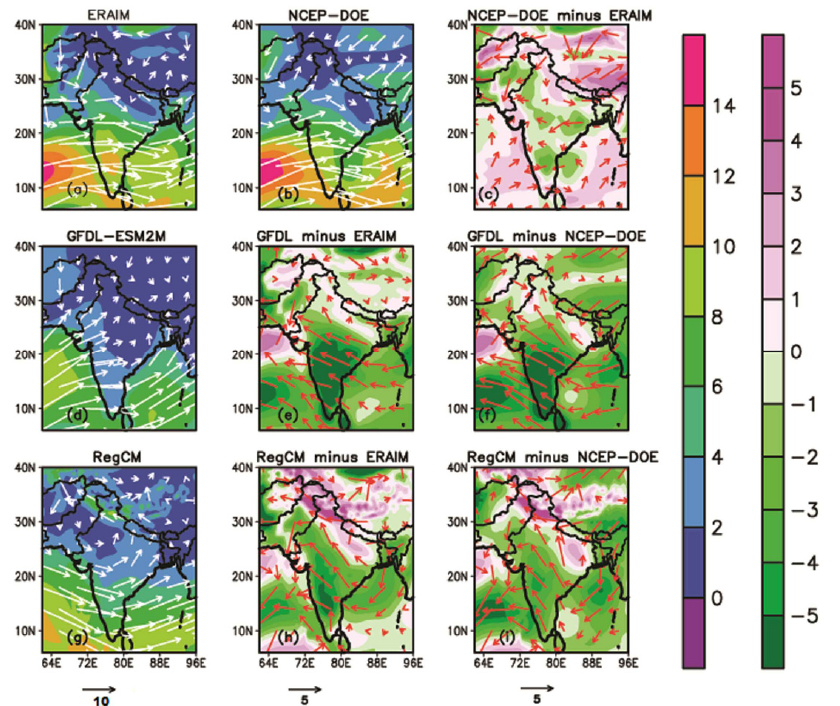
Figure 5. Spatial distribution of SASM mean low level wind (850 hpa) speed (shading, m/s) and direction (arrows) for ( a , b ) ERA Interim and NCEP observations; ( c ) biases in observation; ( d – f ) GFDL − ESM2M and its biases with respect to observations; ( g – i ) RegCM4 and its biases with respect to